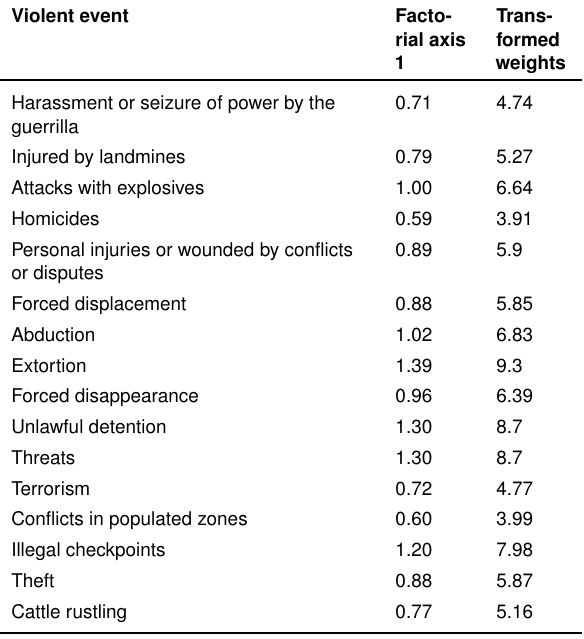
Table 6. Weights associated with the HSI* using binary